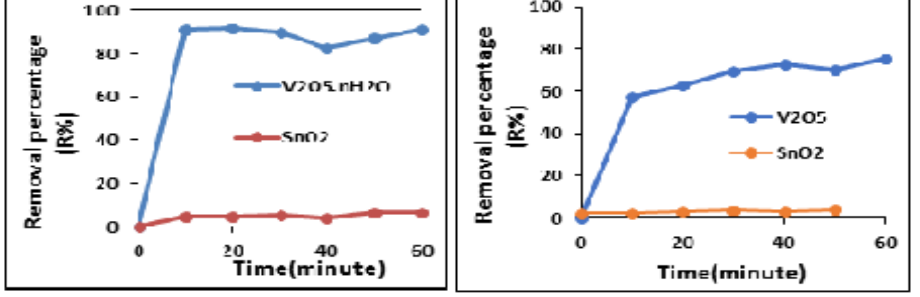
Figure (8): The removal percentage (R%) of BTB onto V 2 O 5 .nH 2 O and SnO 2 nanoparticles heating at 90 ◦ C and 500 ◦ C for 60